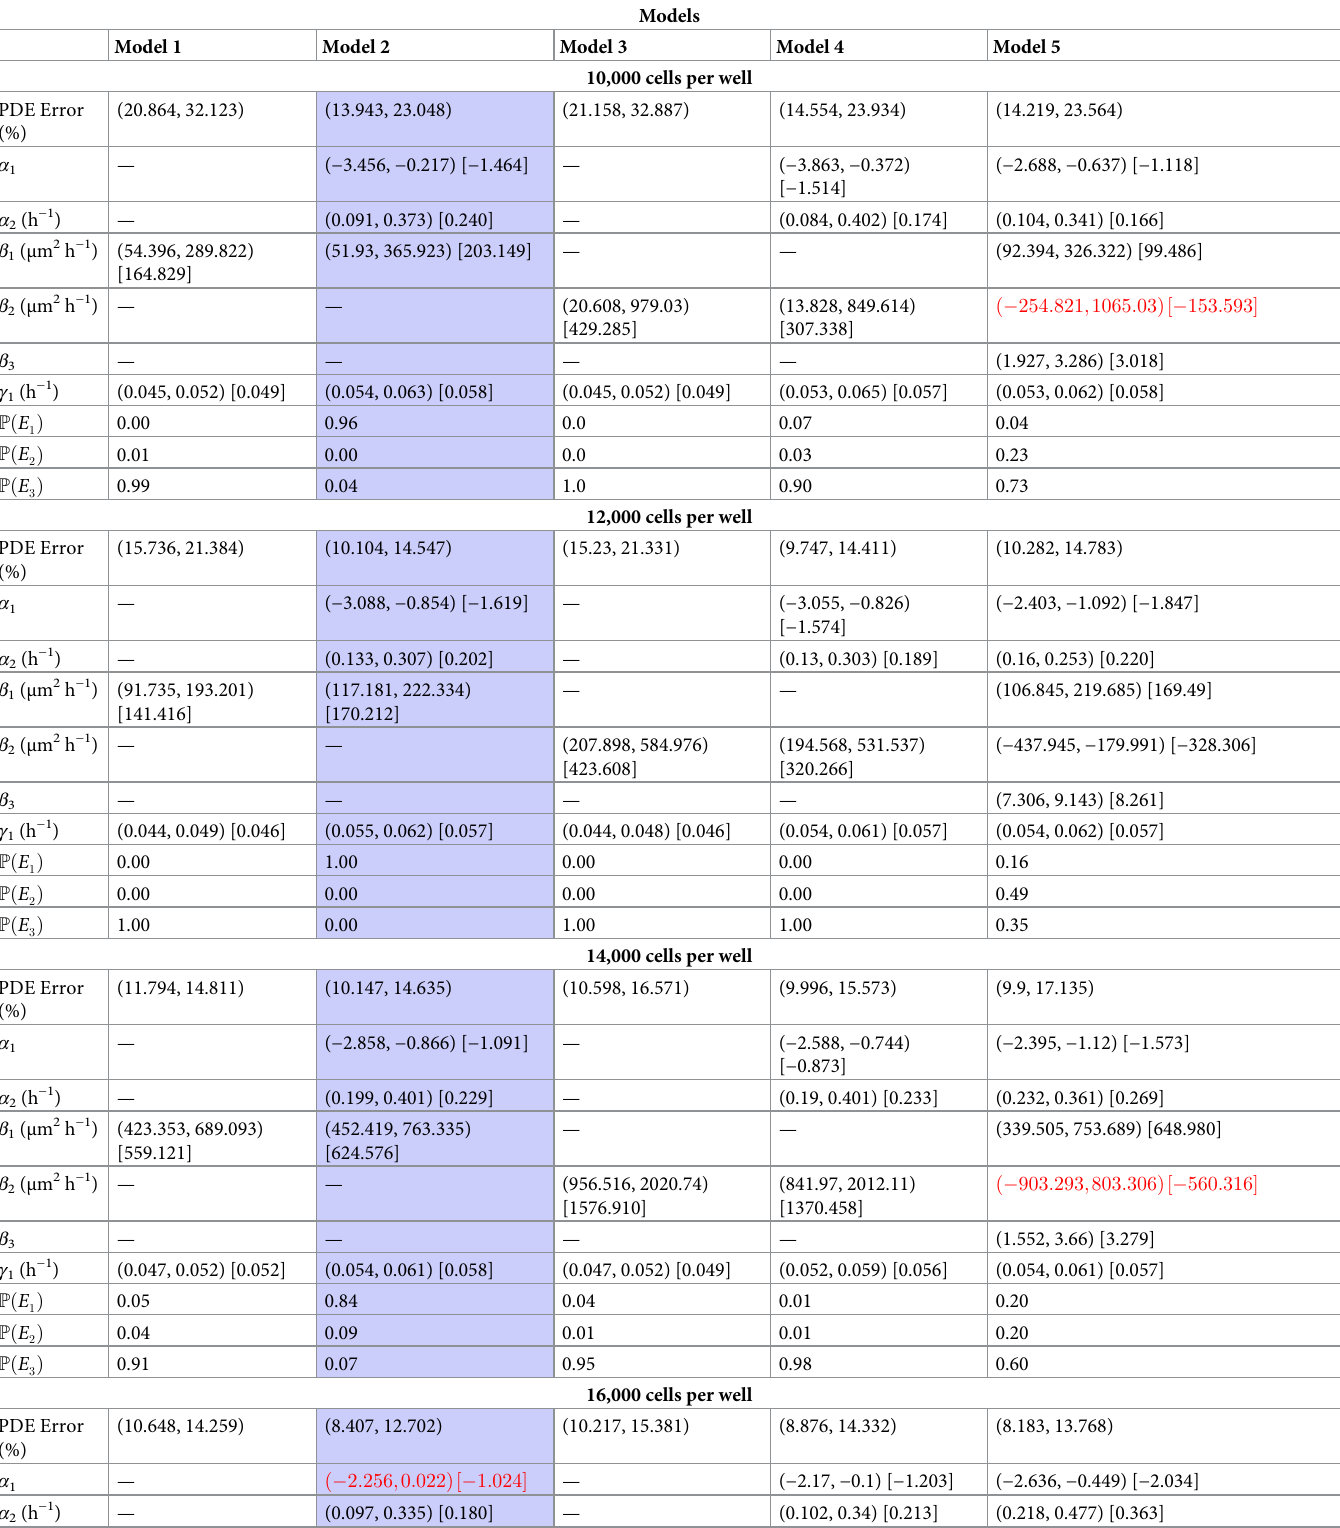
Table 1. Model selection results for the five models